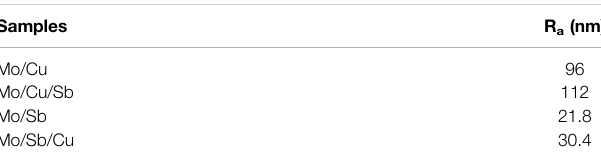
TABLE 1 | Surface roughness of the Mo/Cu, Mo/Cu/Sb, Mo/Sb, and Mo/Sb/Cu layers.